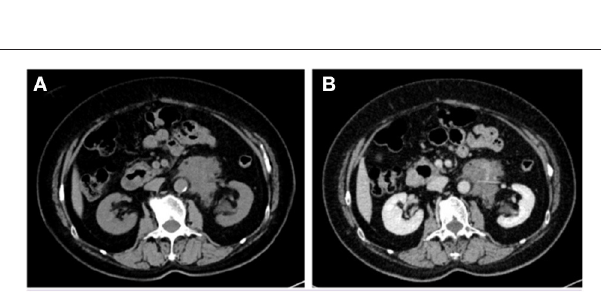
FIGURE 2 | CT showed a large thin-walled cystic mass of low density (A) with no enhancement (B) . 13.9% were hard in texture. Their sections were majorly gray pink